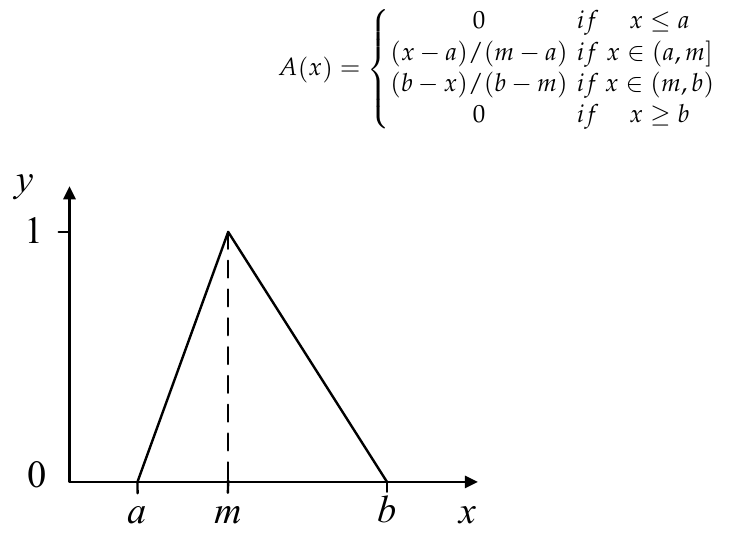
Figure 5. Triangle membership function.